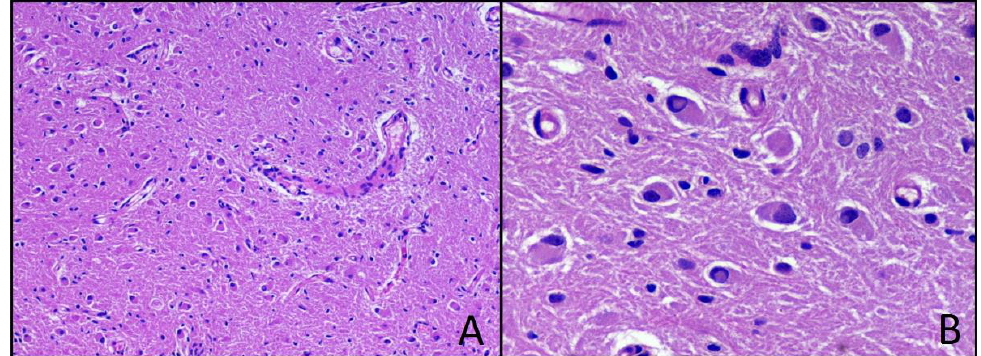
Figure 3. Ganglioglioma. Hematoxylin-eosin-stained photomicrographs with original magnification 100× ( A ) and 400× ( B ).